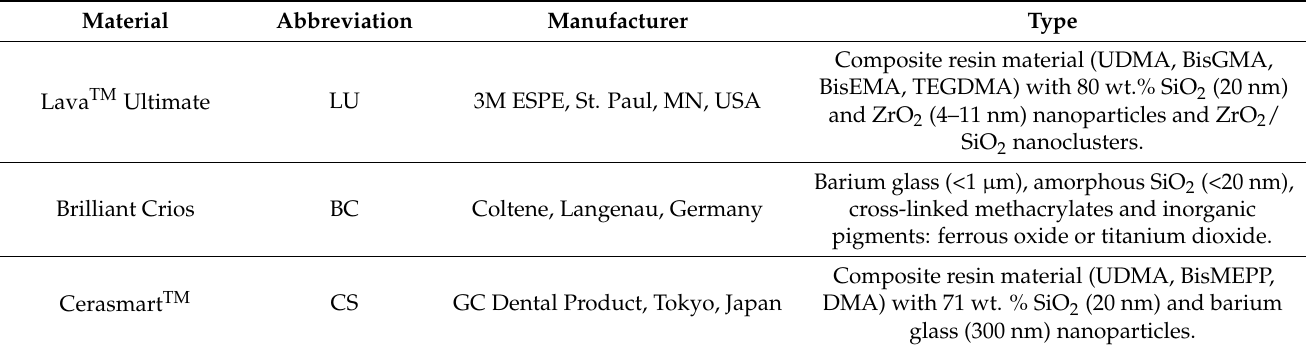
Table 1. Composition of the studied materials from their manufacturers’ technical